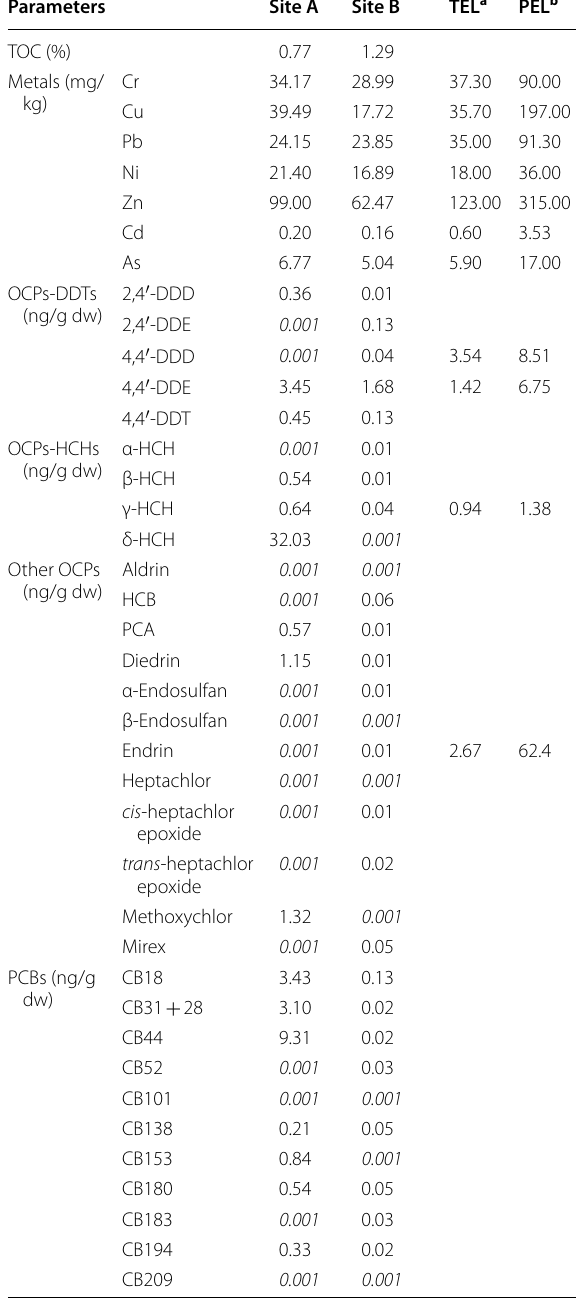
Table 1 Chemical analysis of surface sediments collected from the caging sites A and B in the Taihu Lake